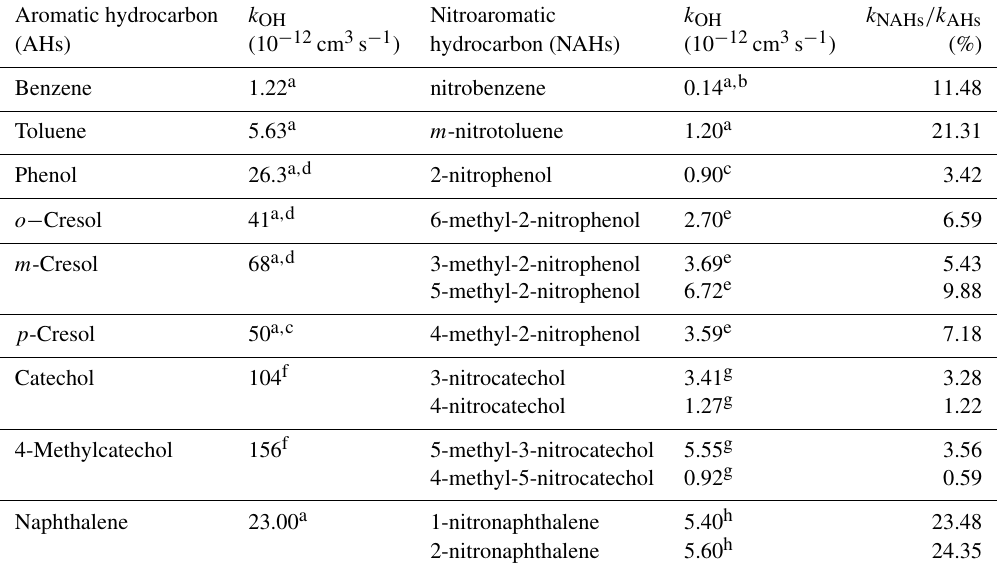
Table 3. Rate coefficients at 298K for aromatic hydrocarbons (AHs) and their correspondent nitroaromatic (NAHs) derivatives for the gas-phase reaction with the OH